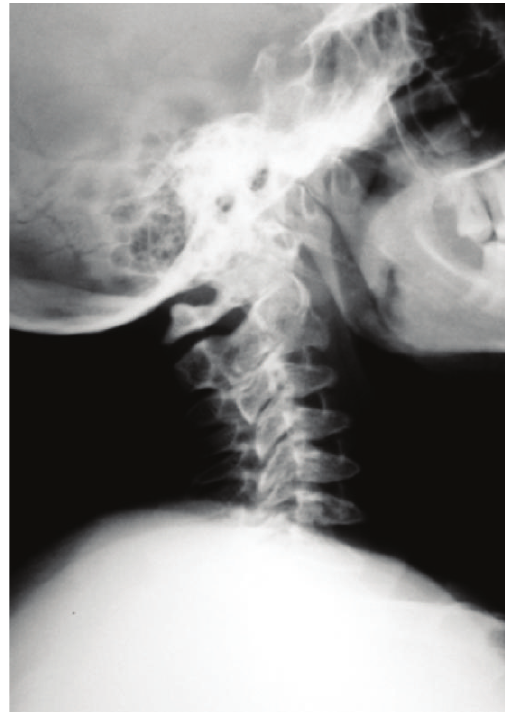
Figure 2: XR lateral view of the cervical spine with wedge shaped vertebral bodies and hypoplasia of the odontoid process.